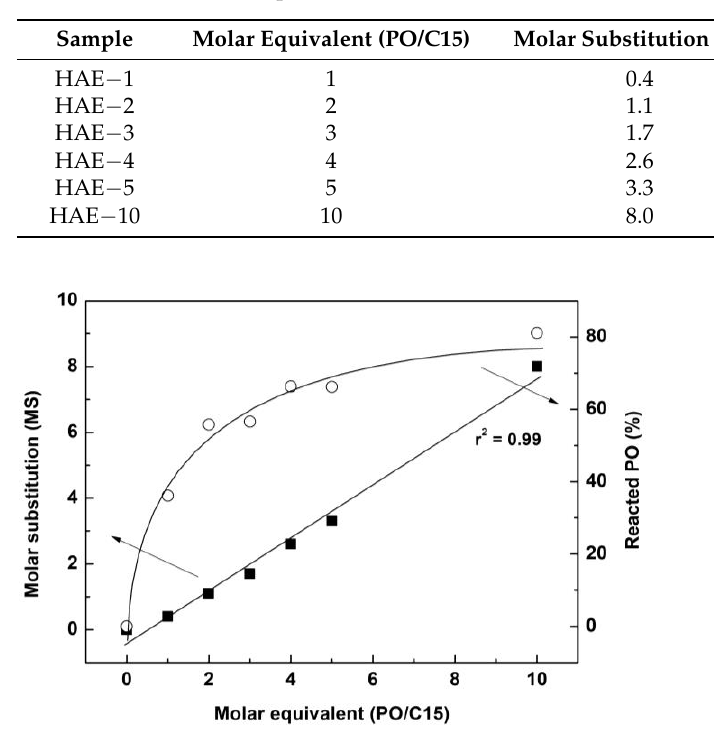
Figure 2. Relationship between molar substitution (MS) vs. molar equivalent (PO/C15) (filled squares) and reacted PO vs. molar equivalent (empty circles). C15: number of carbons in catechin, basic unit of proanthocyanidins in P. radiata bark.